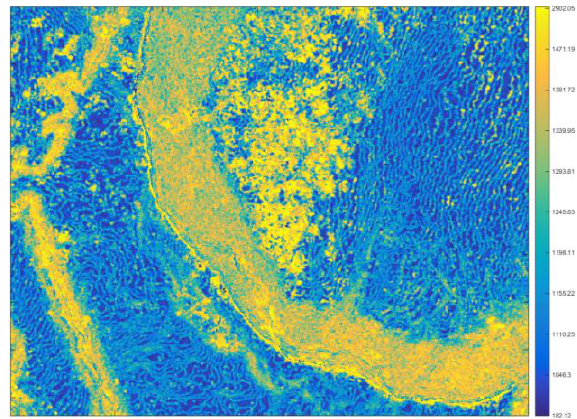
Figure 8. Normalized point density for Scenario 1